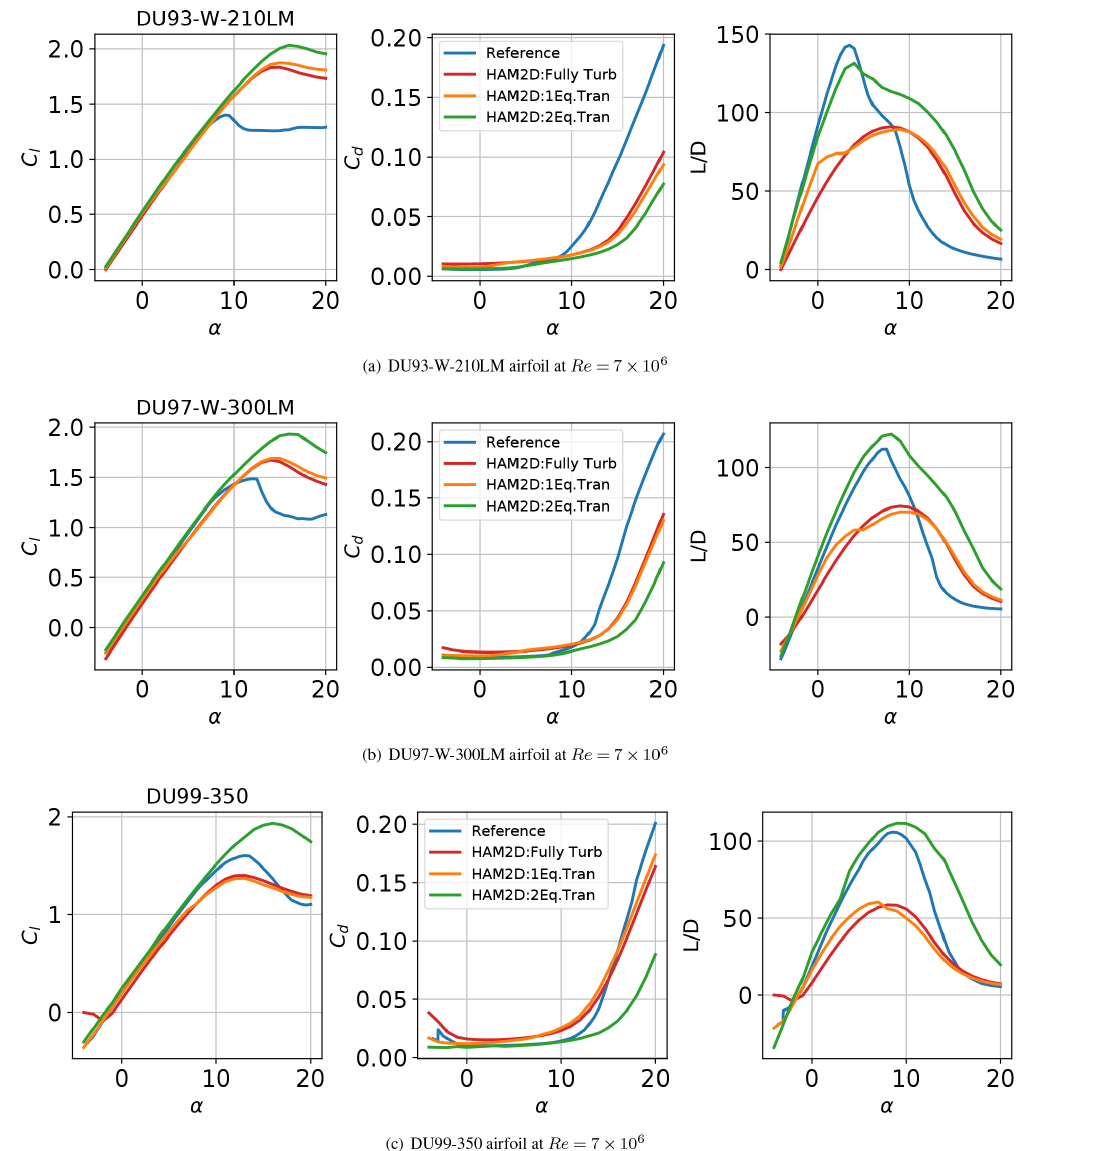
Figure A1. Aerodynamic coefficient polars for DU airfoil series using fully turbulent and free-transition results at Re = 7 × 10 6 generated using HAM2D compared against reference data from Kooijman et al.